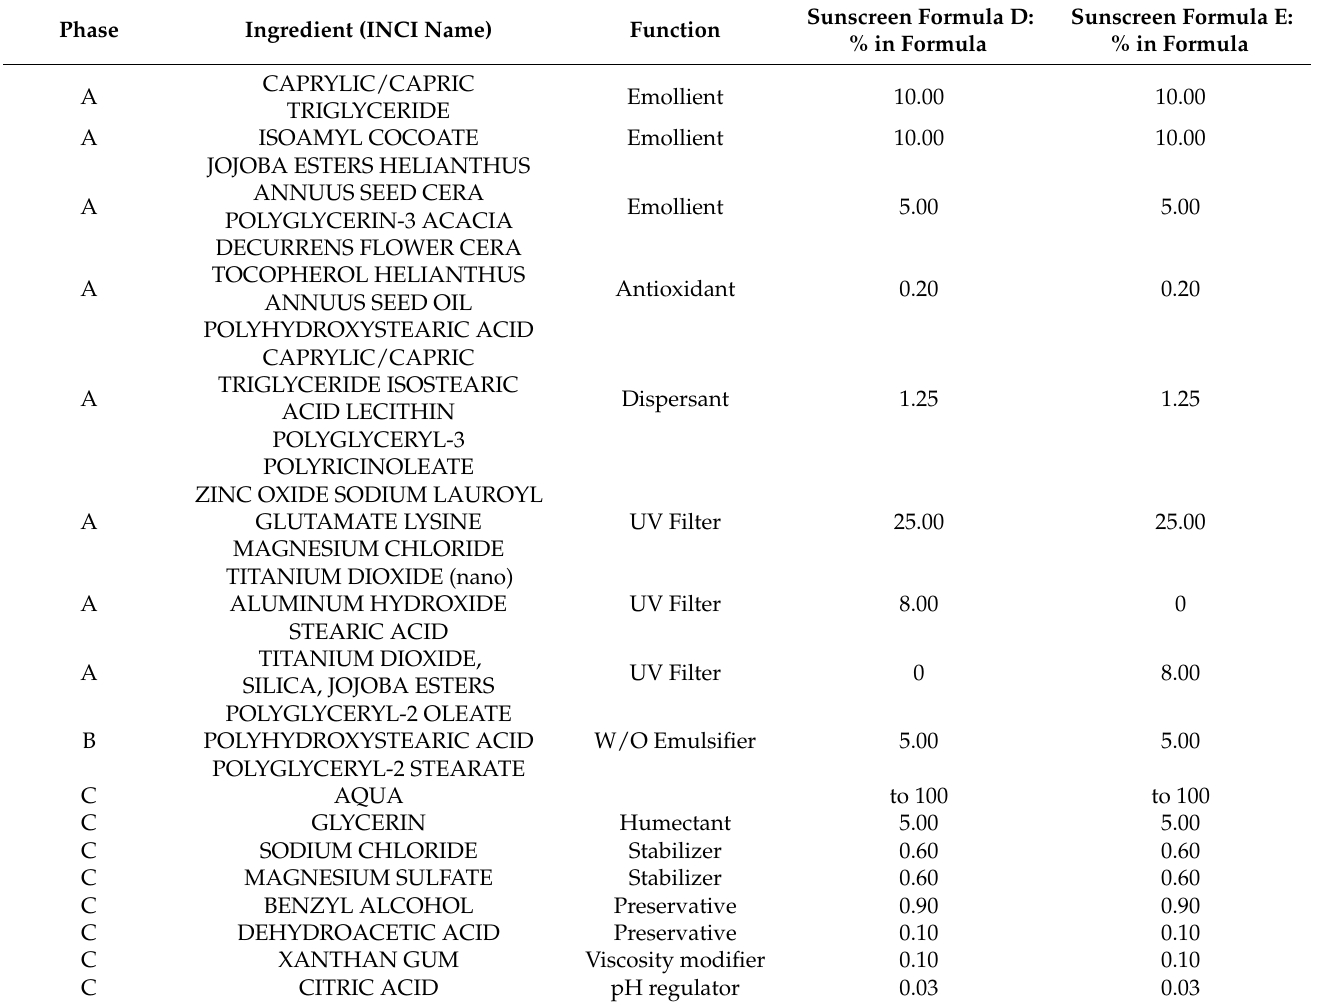
Table 3. Sunscreen formulas D and